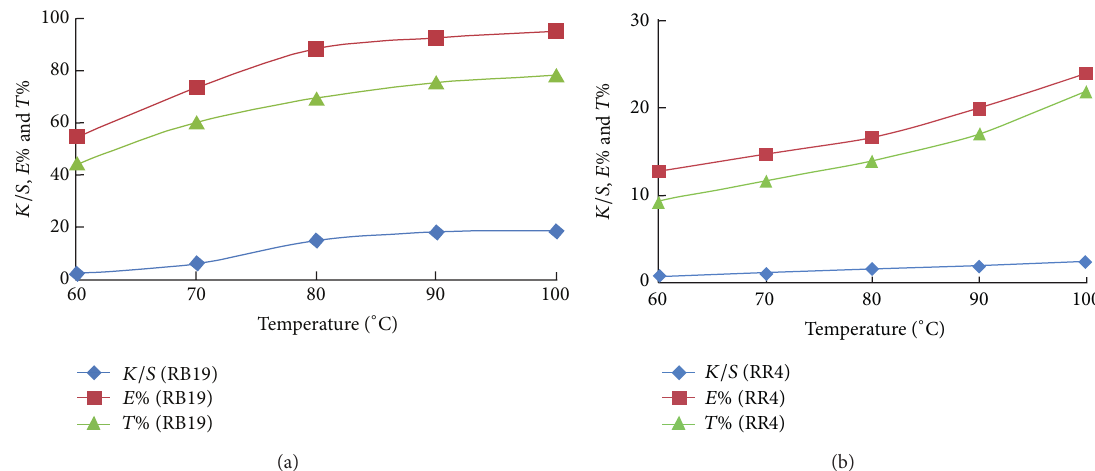
Figure 2: Effect of temperature on the exhaustion, total fixation, and colour strength of CI reactive blue 19 (A) and CI reactive red 4 (S) on amidoximated acrylic fabrics; dyeing conditions: shade 2% owf, liquor ratio 40 :1, pH 2.5, for 60 min.